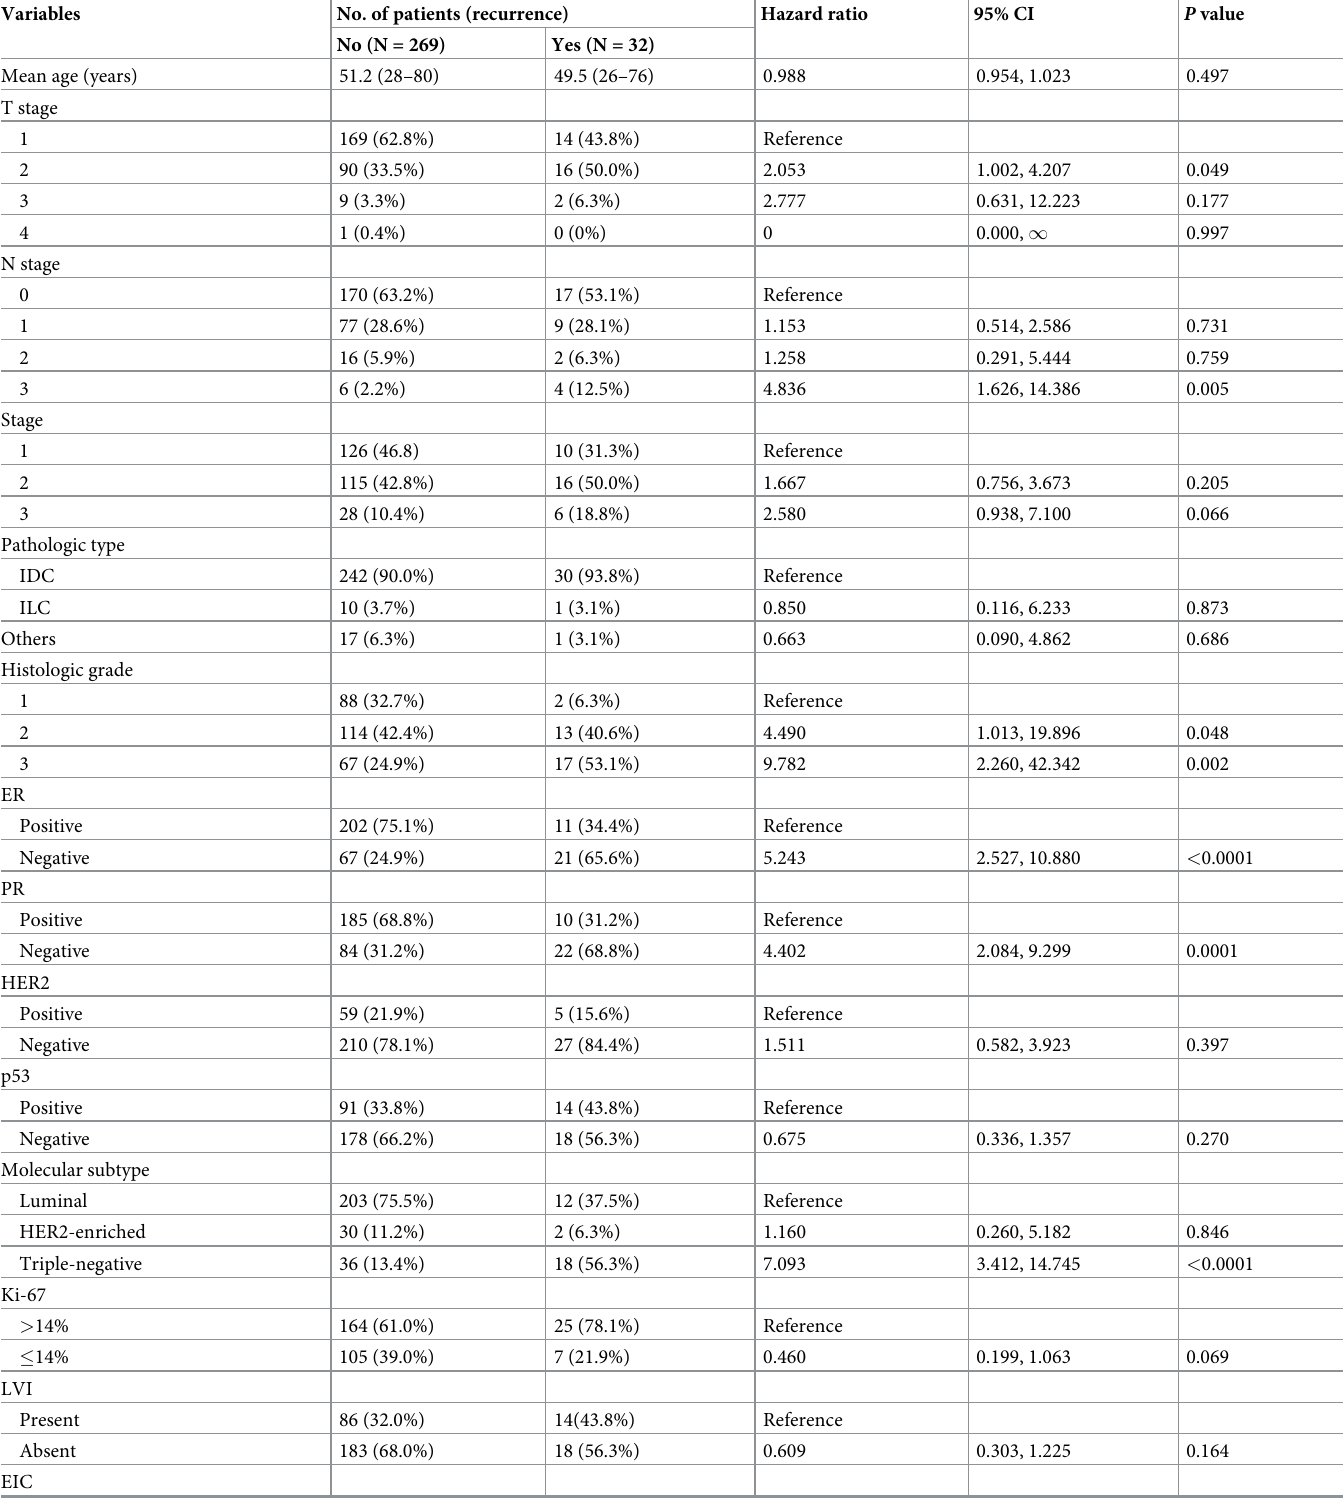
Table 1. Univariate Cox proportional hazard analysis of clinicopathological variables with survival